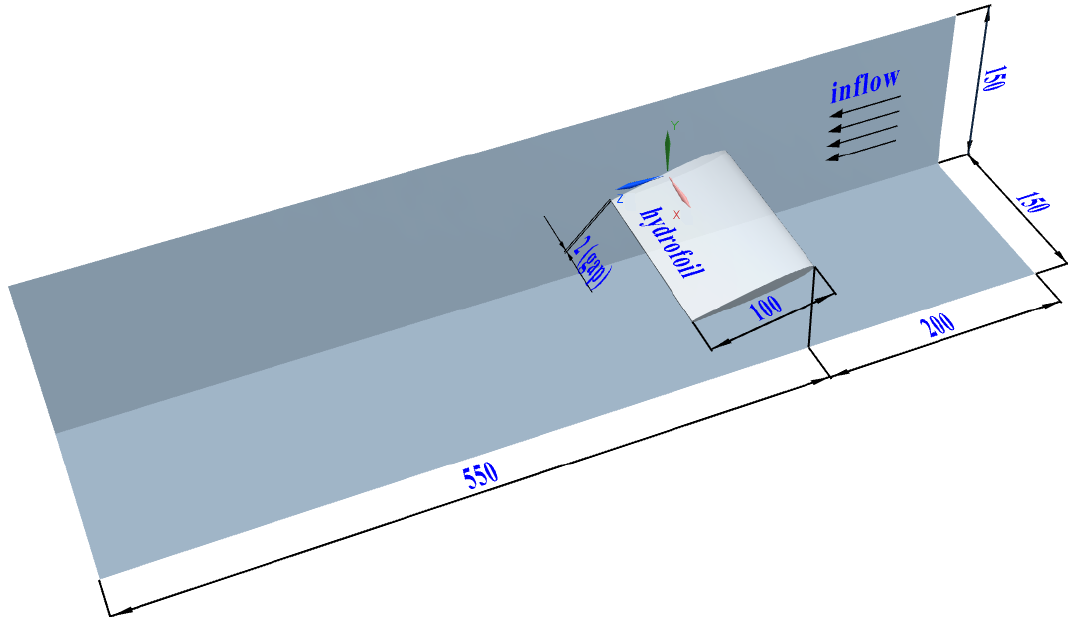
Figure 1. Computational domain with Cartesian coordinates.